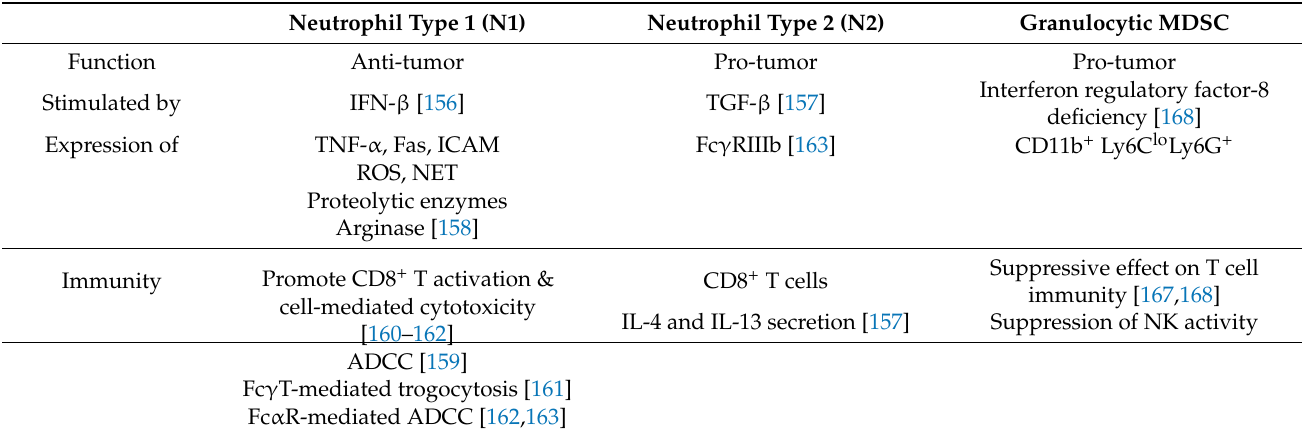
Table 3. The functions and characterization of different heterogeneity of neutrophil subpopulations including N1, N2, and granulocytic MDSCs, relevant to the